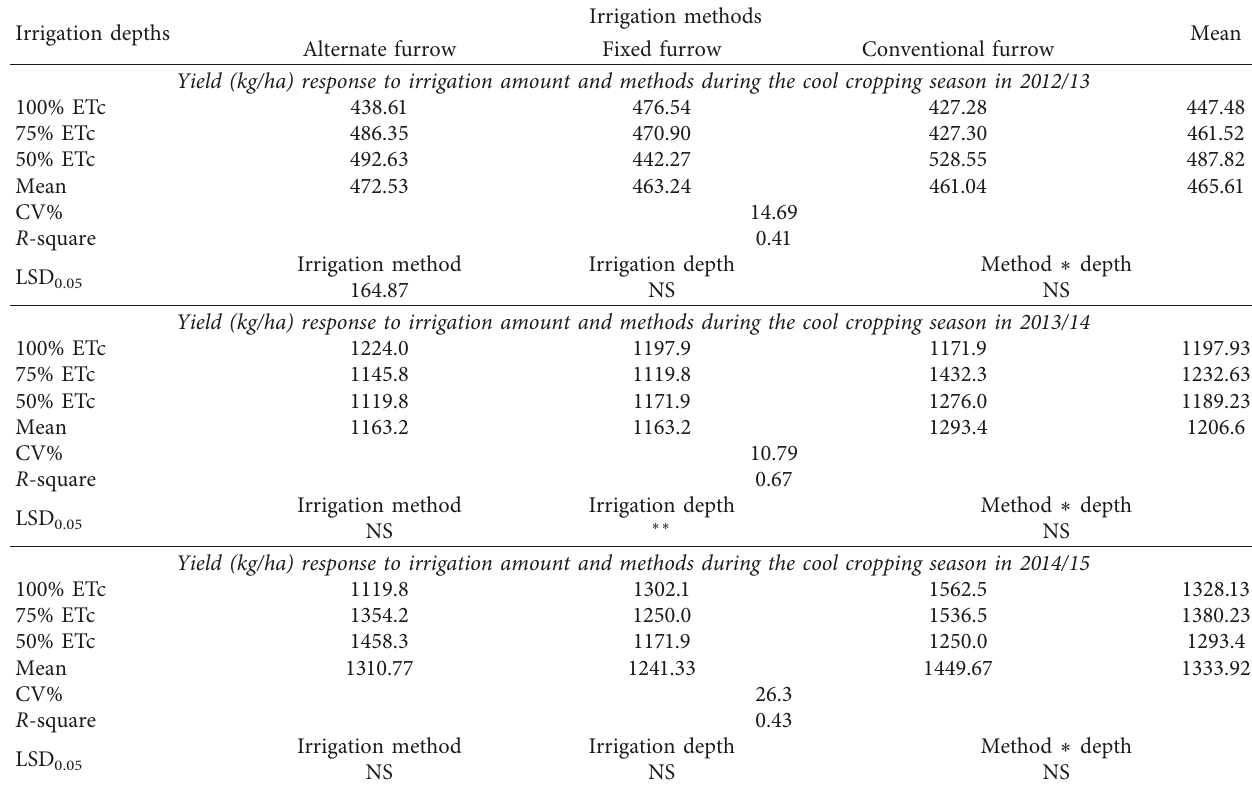
Table 5: Sesame yield response to deficit irrigation in kg/ha during the cool cropping season in 2013–2015. Irrigation